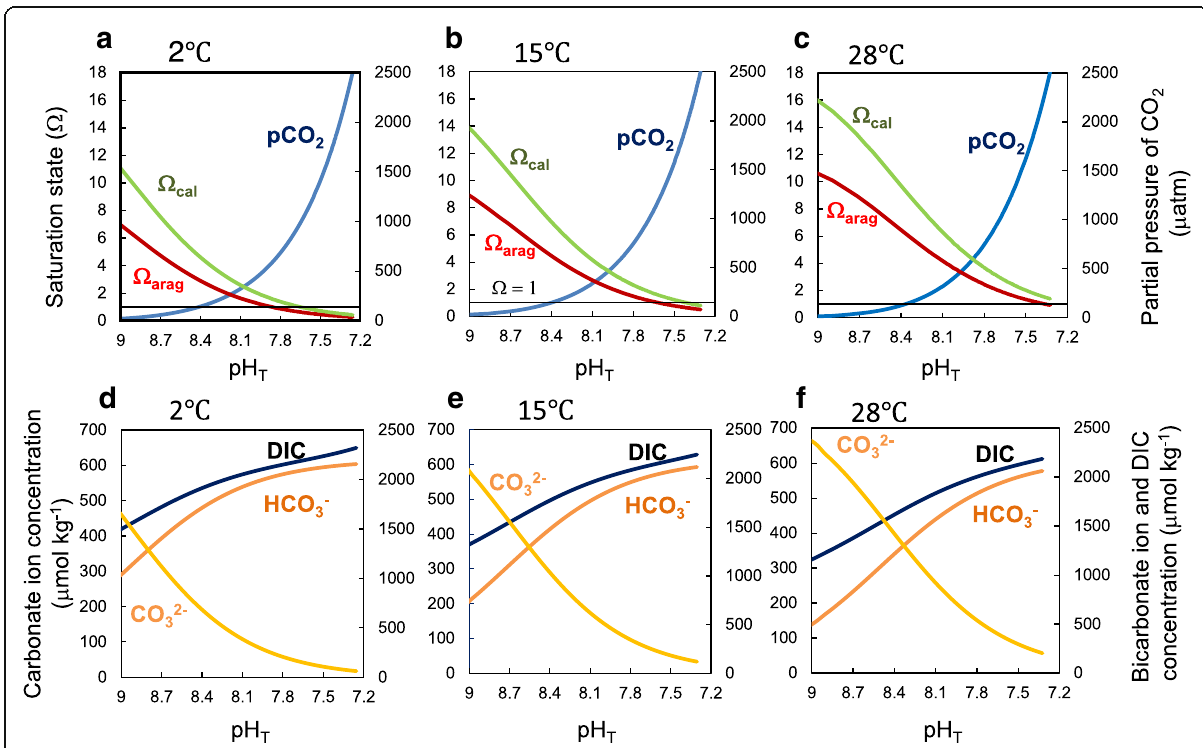
Fig. 3 Upper panels: changes in p CO 2 in seawater and the corresponding saturation states of calcite and aragonite ( Ω cal and Ω arag ) as seawater pH decreases under three different climate schemes: a polar and high-latitude regions (2 °C), b temperate (15 °C), and c tropical (28 °C). Lower panels: changes in [CO 32 − ] with the progression of ocean acidification at three different temperature settings of 2 °C ( d ), 15 °C ( e ), and 28 °C ( f ). The corresponding DIC and [HCO 3 − ] are shown in each graph. The chemical equilibrium calculation was conducted using CO2calc (Robbins et al. 2010), with the following conditions: total alkalinity of 2200 μ mol kg − 1 , salinity of 34, and pressure of 10